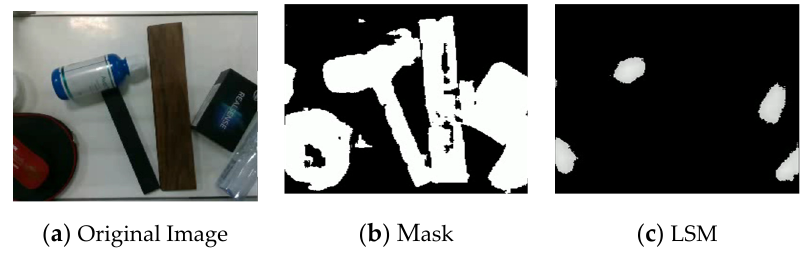
Figure 12. Poor results of LSMNet on the Level 2 video.